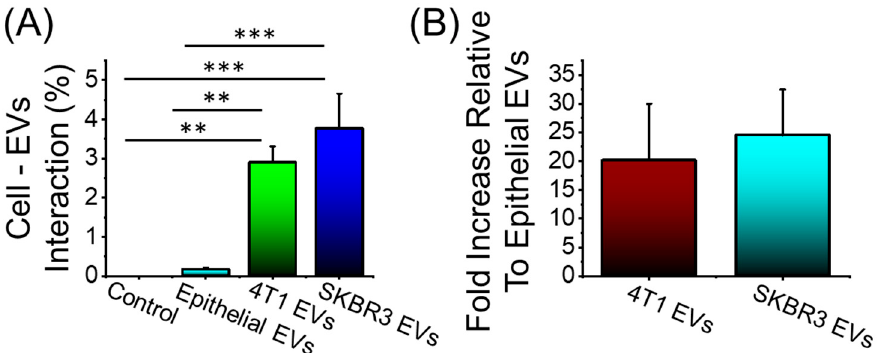
Figure 5. Cellular uptake of PKH26-labeled EVs after 24 h incubation time. ( A ) 4T1 EVs and SKBR3 EVs show a significant accumulation in Y79 cells compared to noncancerous epithelial EVs. ( B ) Fold increase in cancerous EV accumulation in Y79 cells relative to noncancerous EVs. No significant difference in the accumulation among the cancerous EV formulations. Data are presented as mean + SEM for three independent preparations. Significance calculated by ANOVA and is illustrated as follows: ** p < 0.01; *** p < 0.001.